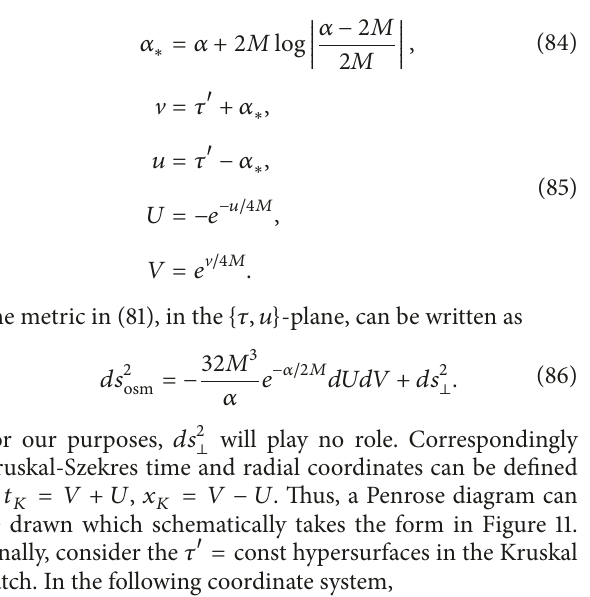
Figure 11: A qualitative picture of the Kruskal extension of the open string metric. We have drawn the Penrose diagram in a “square” form, which is not strictly correct. We will elaborate more on the Penrose diagram in later sections. This diagram is taken from